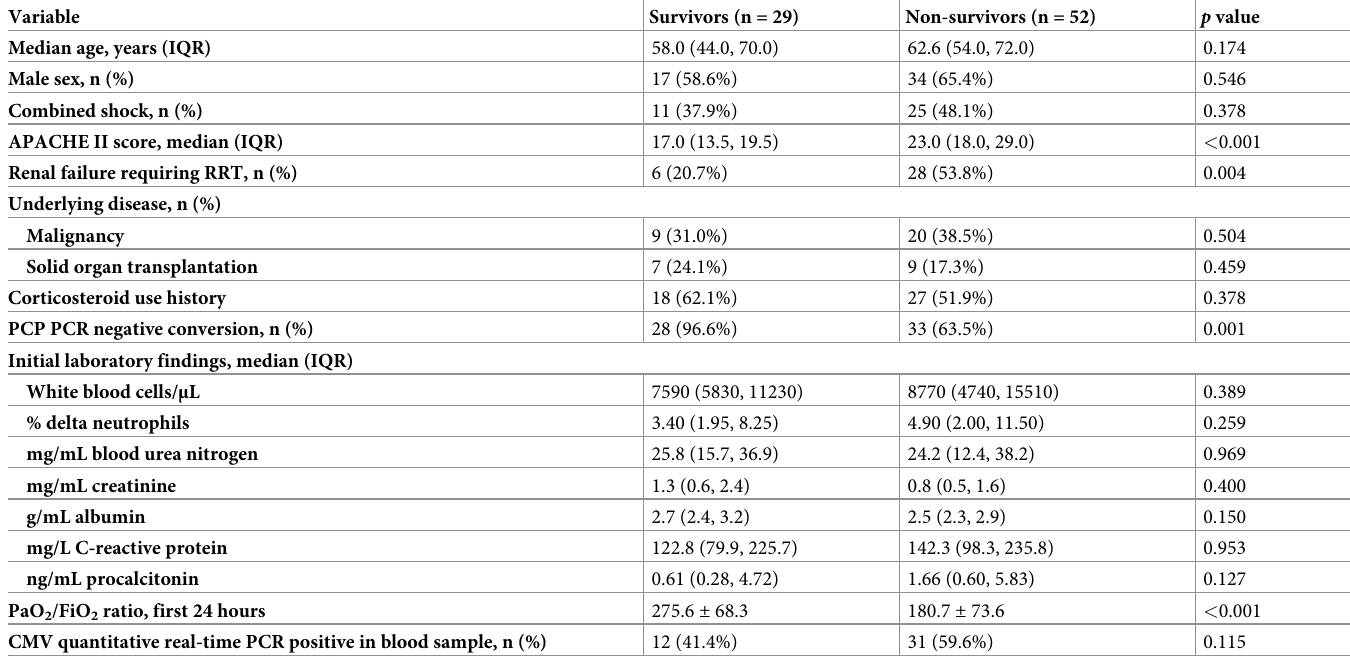
Table 2. Comparison of the characteristics between survivors and non-survivors.